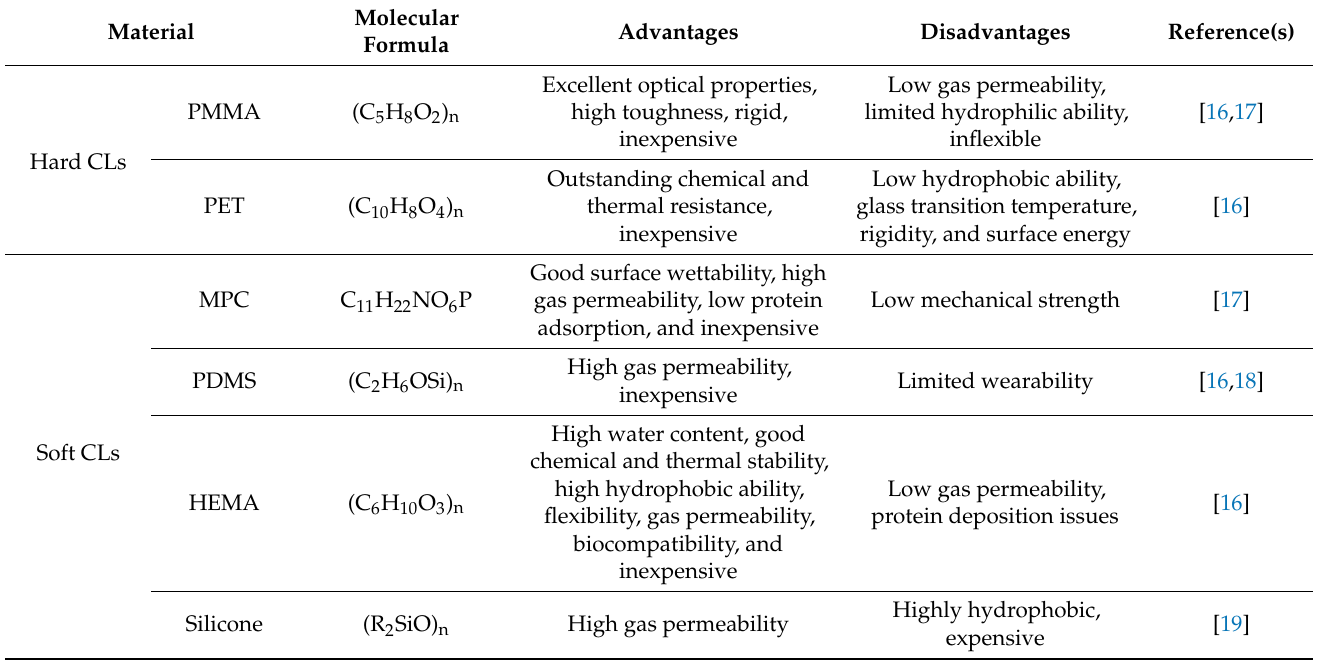
Table 1. Molecular formula and properties of commonly used hydrogels for CLs.